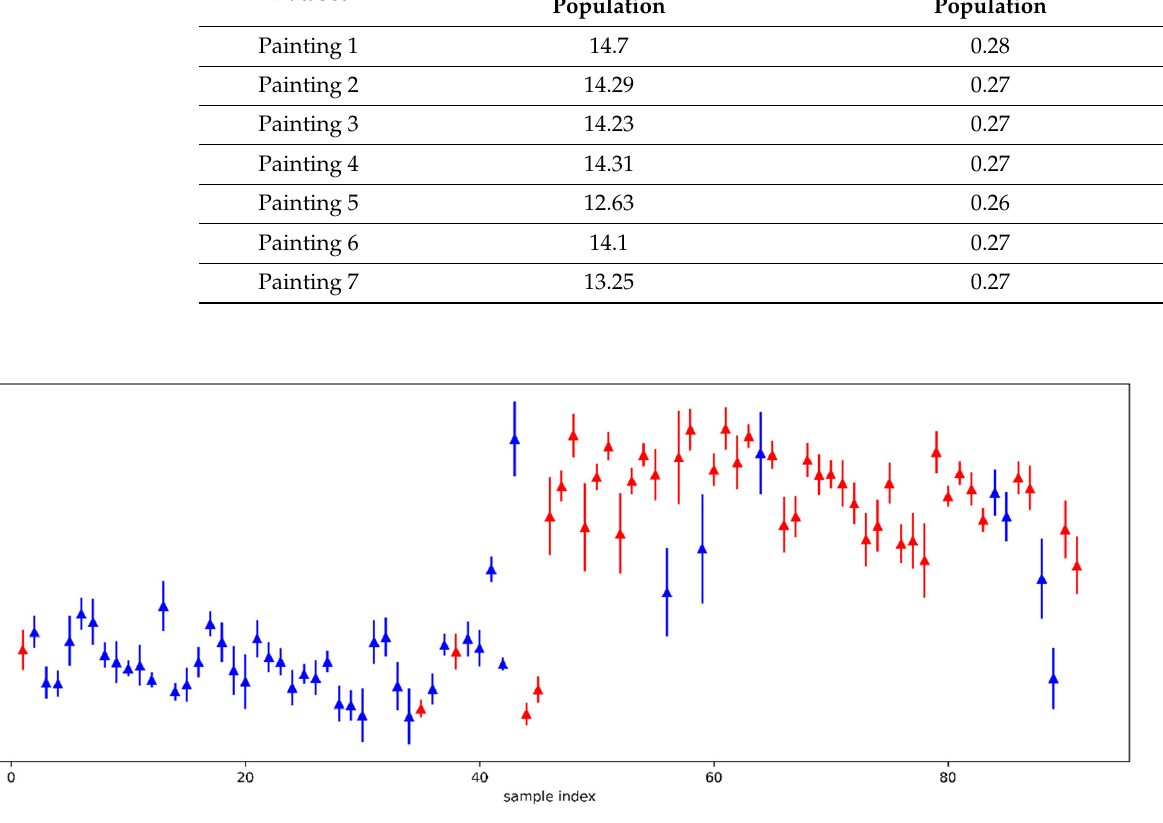
Figure 4. Illustration of the variability of the DGI score over the seven paintings dataset for each patient.